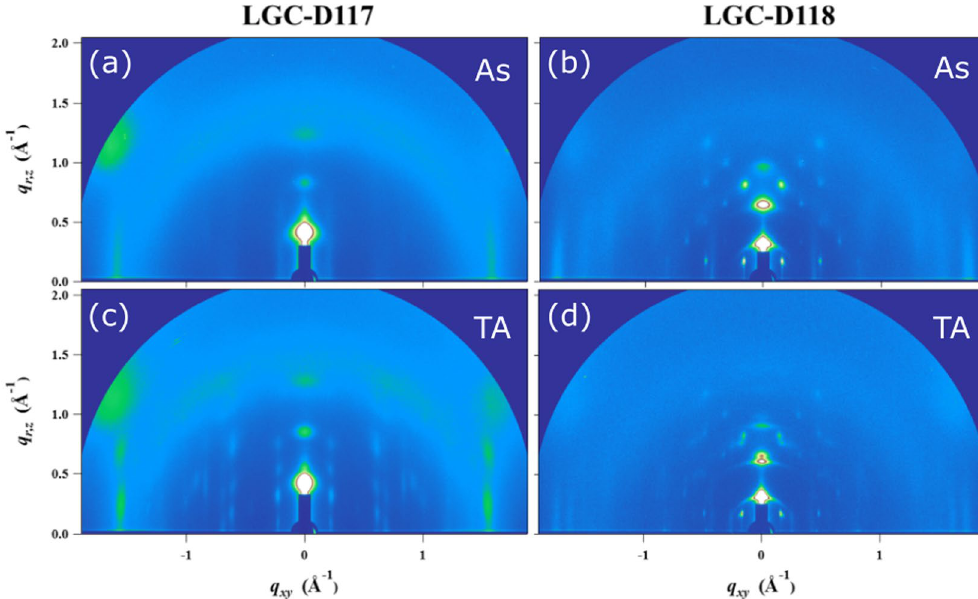
Figure 5. Grazing incidence X-ray diffraction patterns of the as-spun and thermally annealed (140 °C) LGC- D117 [( a ) and ( c )], LGC-D118 [( b ) and ( d